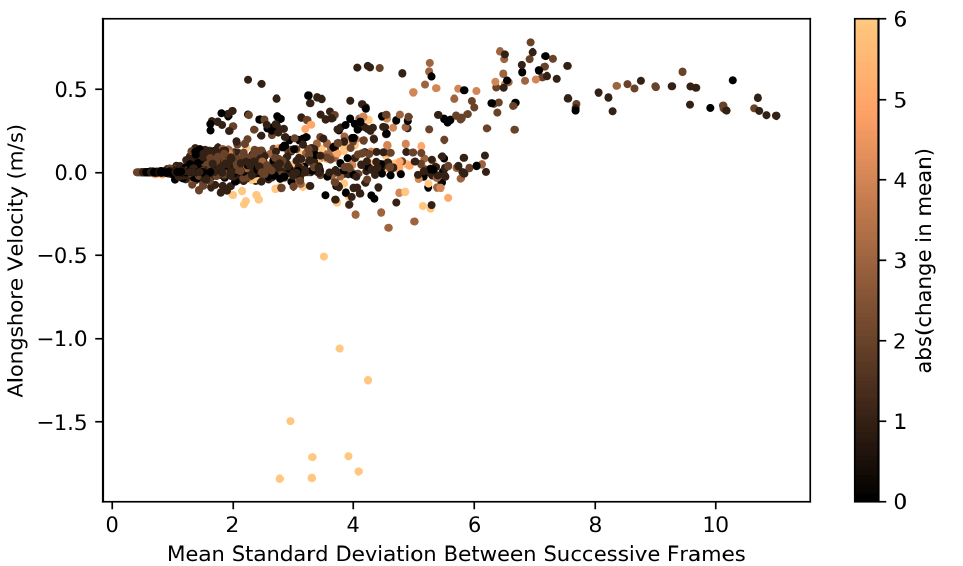
Figure 4. All alongshore velocity estimates from the green 5 × 5 m box in Figure 3 during a single 17 min WAM. The majority of returns are positive (northward), but anomalously large negative velocities are all associated with large jumps in the mean local brightness between frames and many zero velocity returns are associated with low local standard deviation of brightness (effectively limited texture on the water surface to